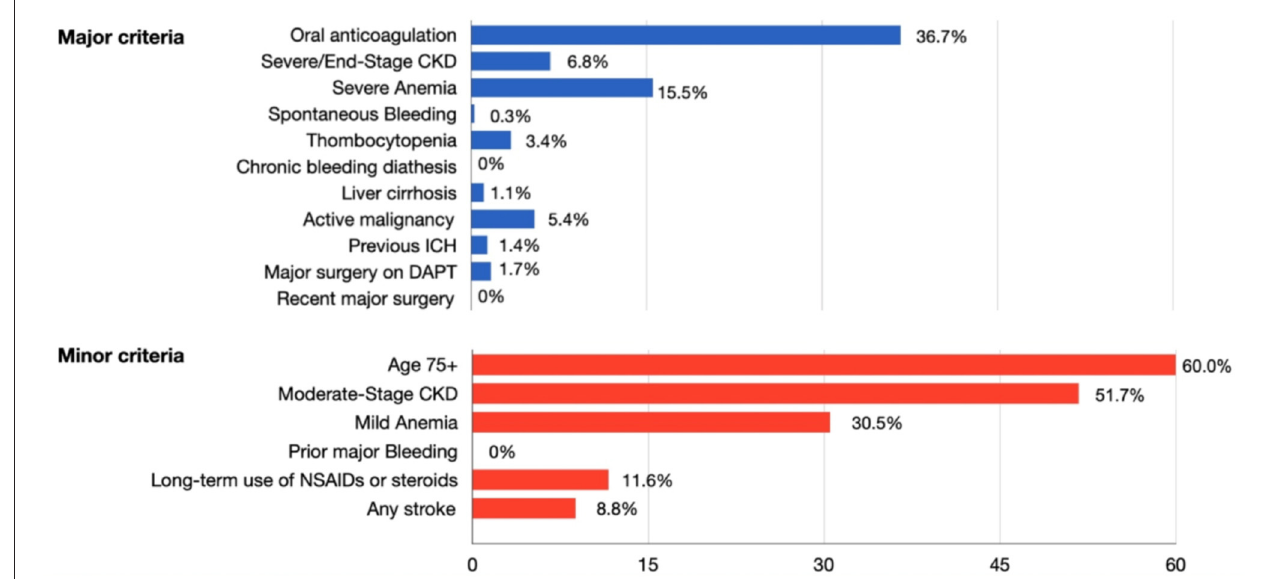
FIGURE 1 | Prevalence of the ARC-HBR criteria in the HBR group. ARC, Academic Research Consortium; CKD, chronic kidney disease; DAPT, dual antiplatelet therapy; HBR, high bleeding risk; ICH, intracerebral hemorrhage; NSAIDs, non-steroidal anti-inflammatory drugs.